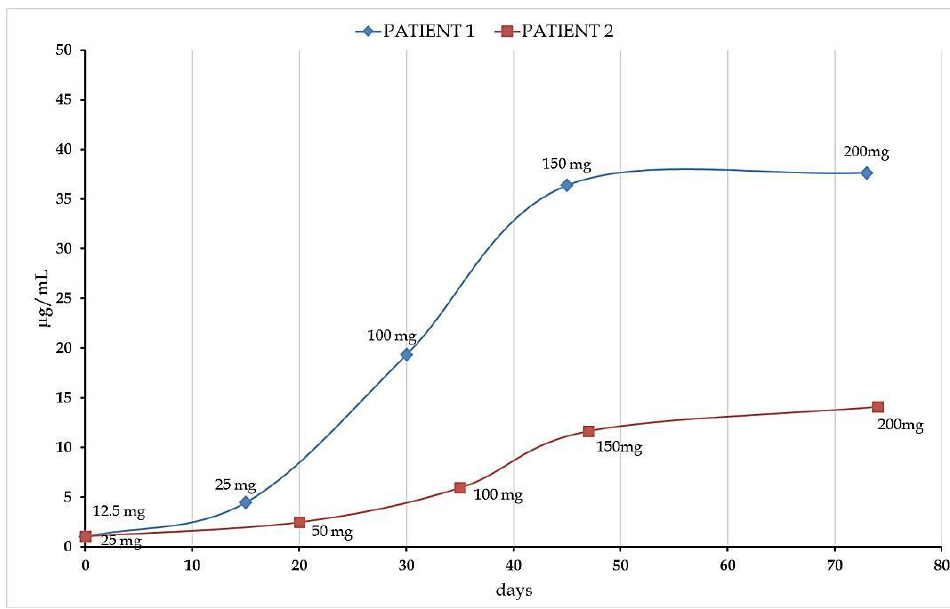
Figure 5. Plasma drug concentrations observed in two young adult patients under CNB treatment. Curve points represent CNB dosage at follow up. Curve points represent CNB dosage at follow